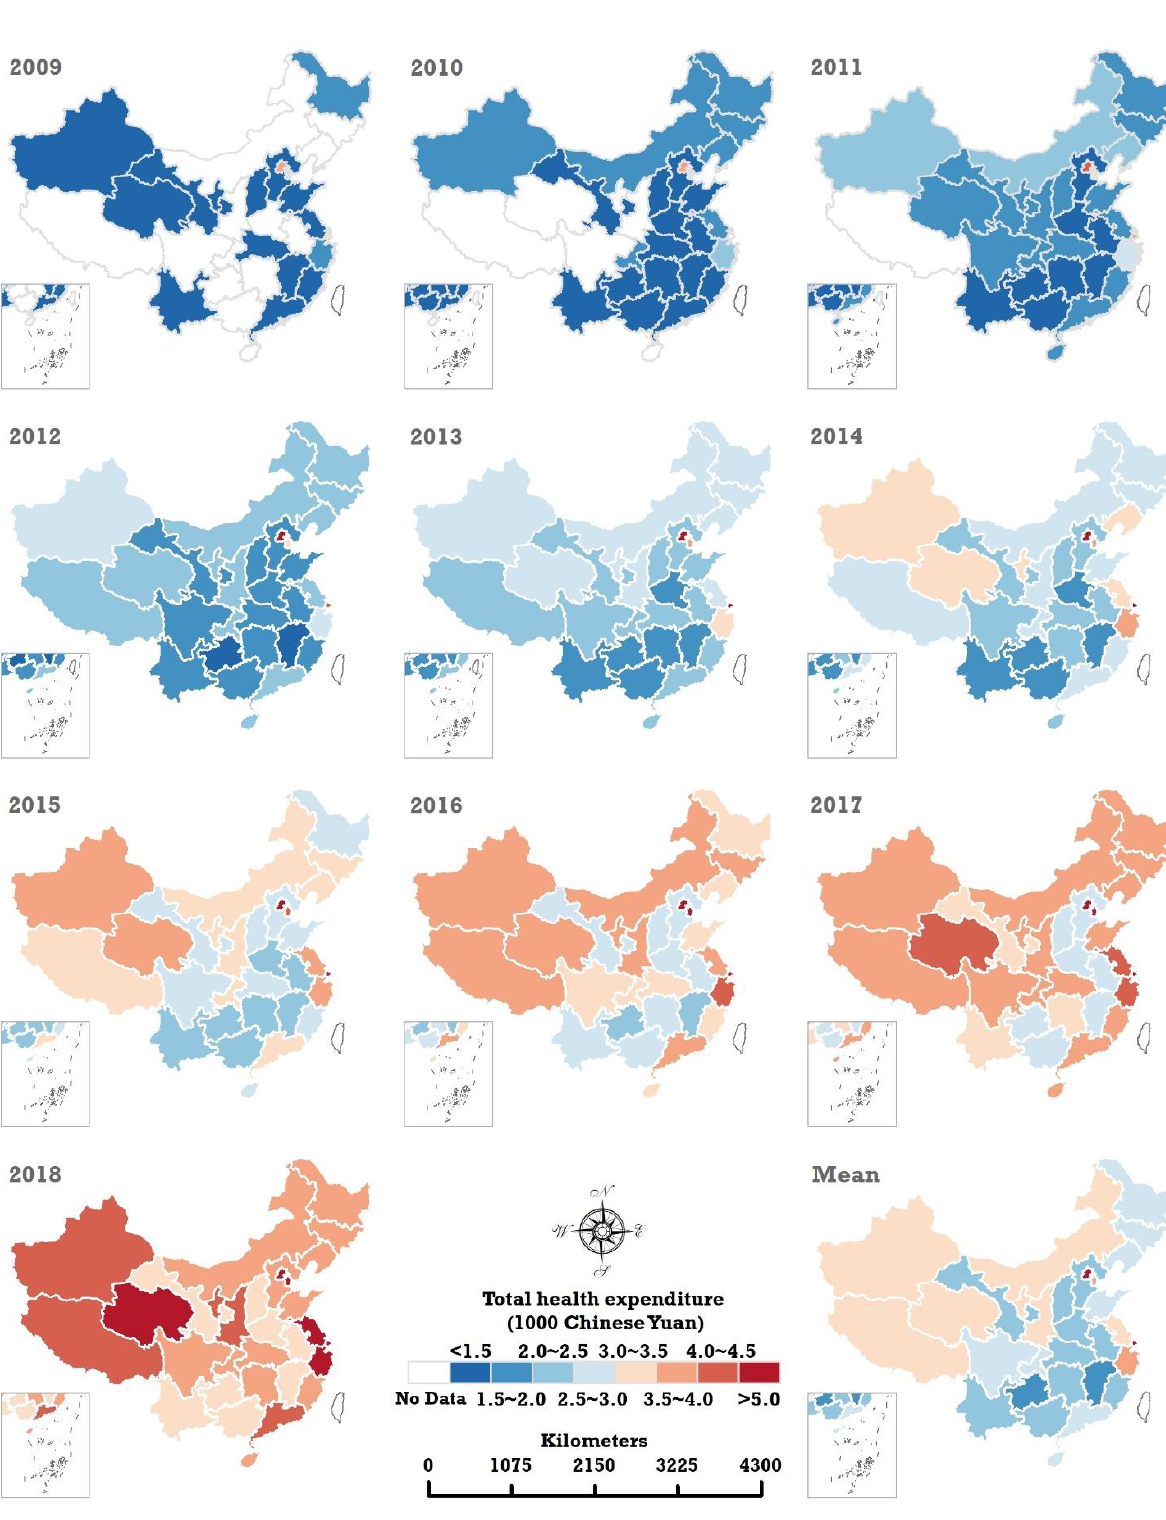
Figure 4. Spatiotemporal sequence map and spatial pattern of the mean THEE in China from 2009 to 2018.